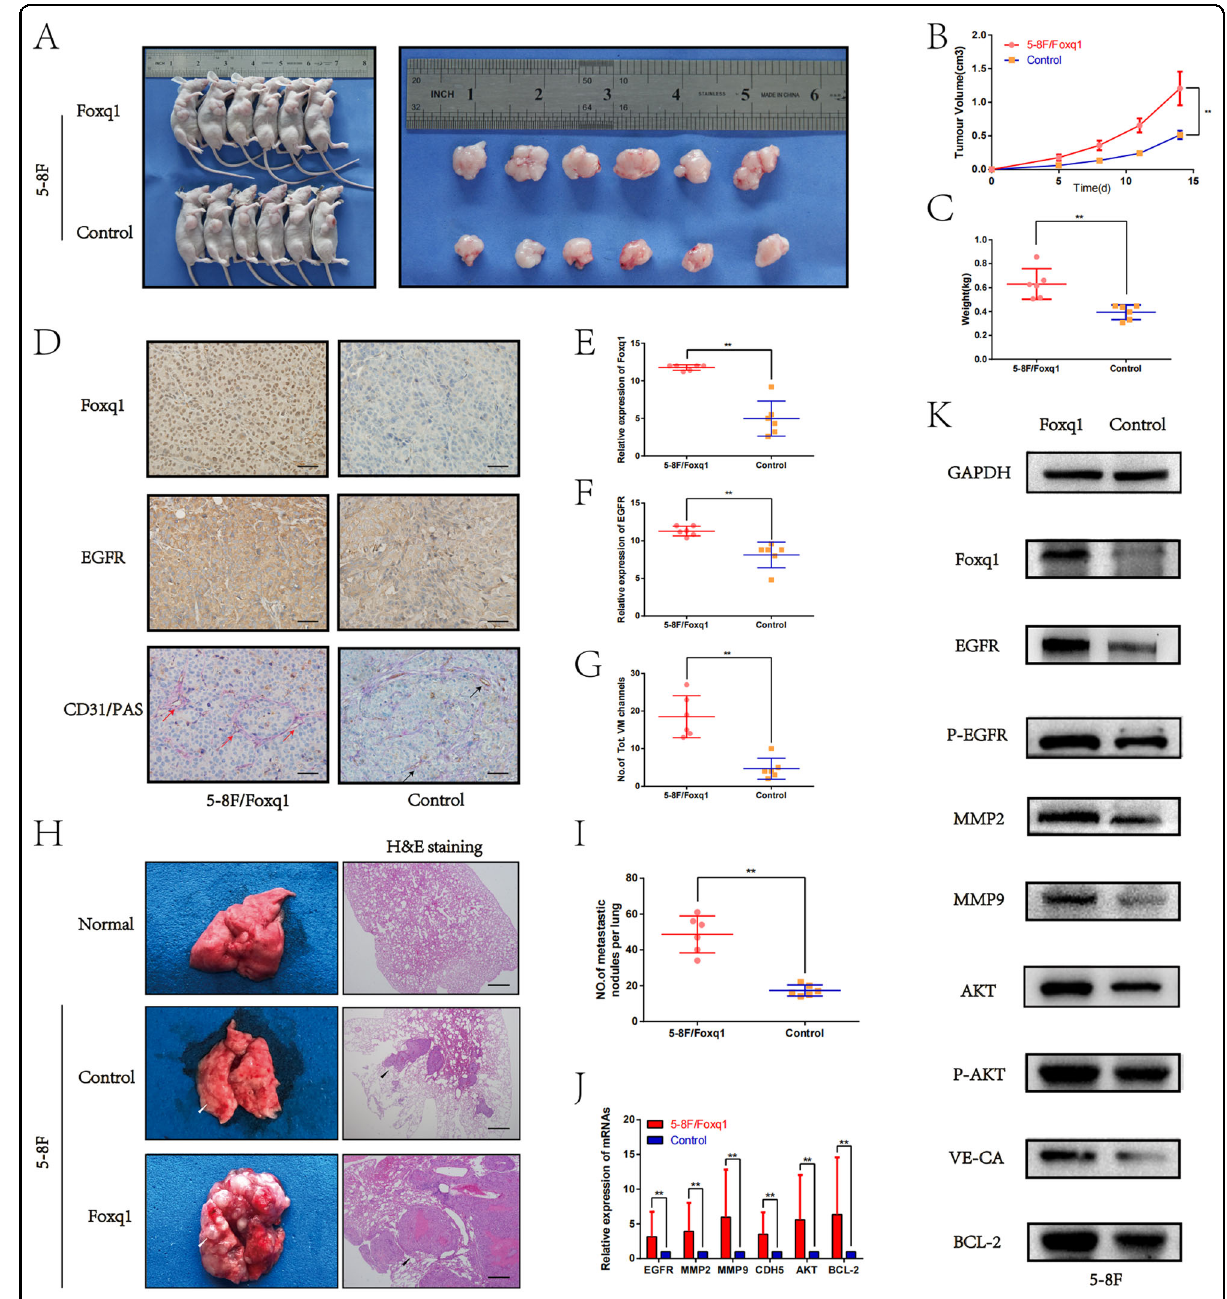
Fig. 5 Foxq1 promotes VM formation, and NPC growth and metastasis through regulating EGFR in vivo. A Image of xenograft tumors from nude mice that were injected with Foxq1 overexpressing or control 5 – 8F cells (after 2 weeks). B The growth curves of xenograft tumors from each group; p < 0.001. C The weight of xenograft tumors from each group; p < 0.001. D IHC of Foxq1, EGFR and PAS/CD31 double staining of xenograft tumors from each group. Red arrows = VM; Black arrows = endothelial vessels; Scale bars represent 50 μ m. E – G Statistical results of Foxq1( p < 0.001), and EGFR ( p < 0.001) expression and VM channels ( p < 0.001) in xenograft tumors from each group. H Metastatic nodules by tail vein injection of each group and normal lung (left). Image of H&E staining of lung sections from each group (right); Scale bars represent 500 μ m. I Statistical results of the metastatic nodules in each group; p < 0.001. The expression of related genes in xenograft tumors from each group were monitored by qRT-PCR ( J ) and western blot ( K ). Data are presented as mean ± SD of three independent